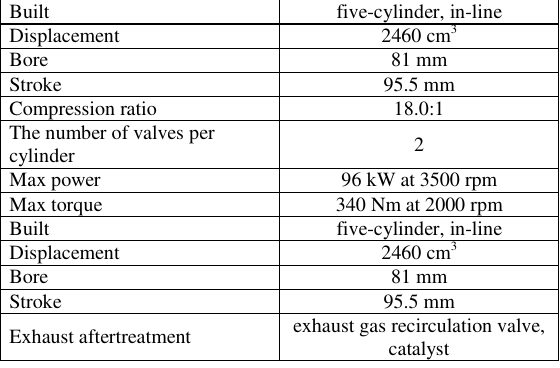
Fig. 9. The standard engine cooling system 2.5 TDI in the car utilitarian VW Transporter T5 [8]: 1 – first heat exchanger, 2 – coolant